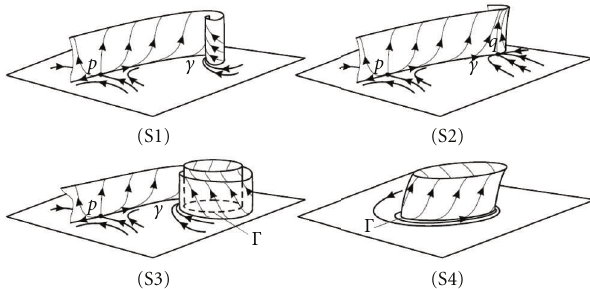
Figure 6: The four types of separation lines (Surana et al. [13]).